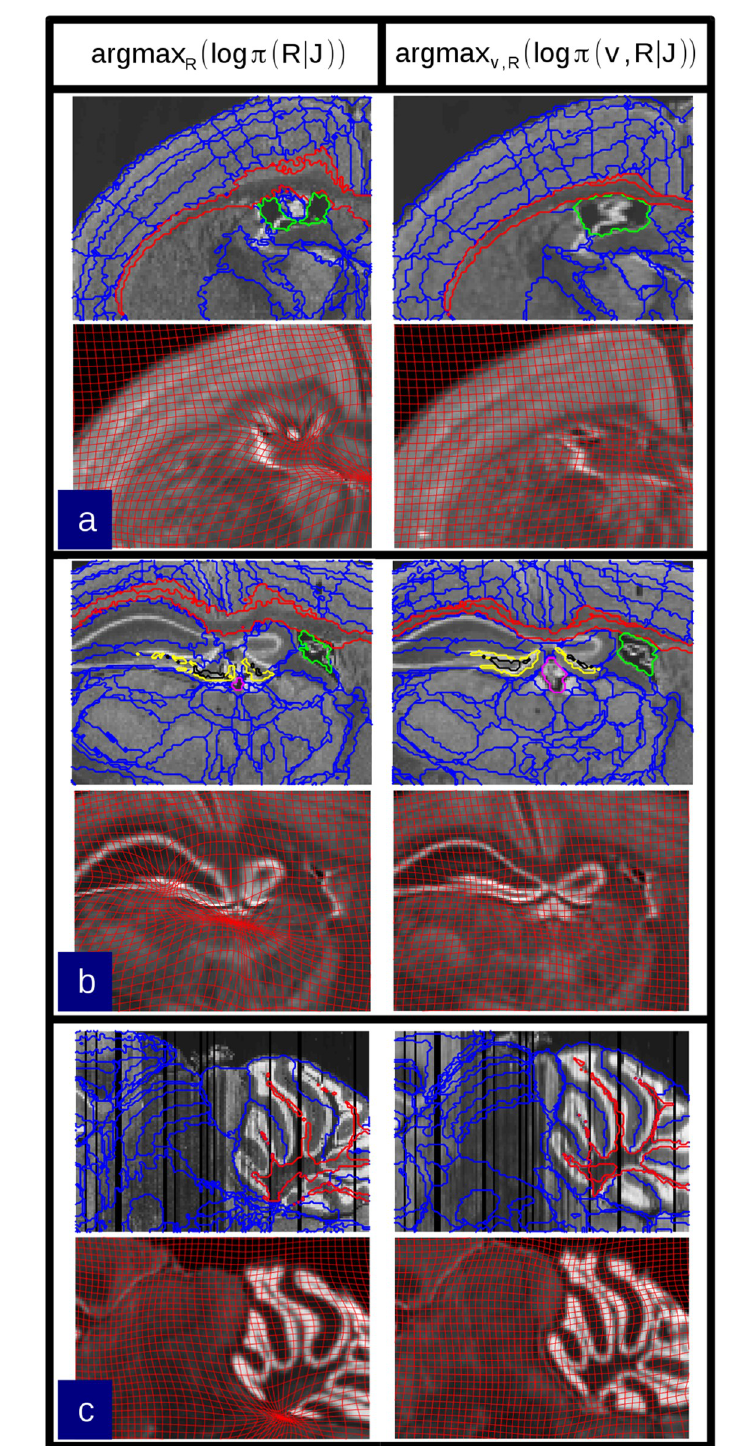
Fig 10. Selected regions of the brain segmented by the atlas-informed and atlas-free models carry the label map from the Allen atlas under the computed diffeomorphism. The left column shows several examples where optimization of the atlas-free solution is trapped in false minima due to folded or low-contrast structures. The right column shows correction by the atlas-informed algorithm. A) The corpus callossum and lateral ventricle. B) The dentate gyrus, corpus callossum, and lateral ventricle. C) The cerebellar white matter.